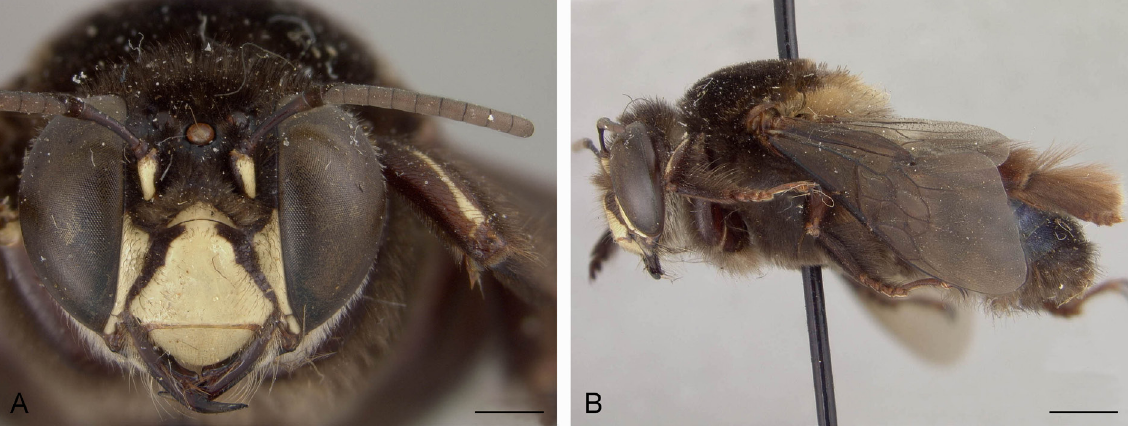
Fig. 4. Centris elegans grenadensis Cockerell, 1919, holotype, ♂ (NMNH; USNM ENT 00534197). A . Frontal view. B . Habitus, lateral view. Scale bars: A = 1 mm; B = 2